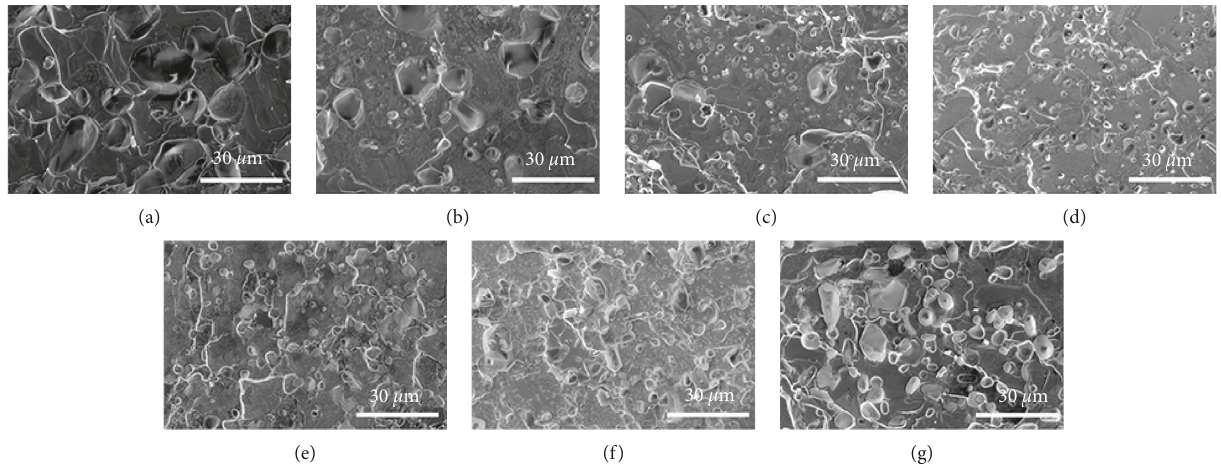
Figure 6: The SEM photographs of the GdBCO samples prepared with PSPP sintered at different temperatures. (a) S1 (25 ° C), (b) S2 (950 ° C), (c) S3 (1000 ° C), (d) S4 (1050 ° C), (e) S5 (1100 ° C), (f) S6 (1150 ° C), and (g) S7 (1200 ° C).